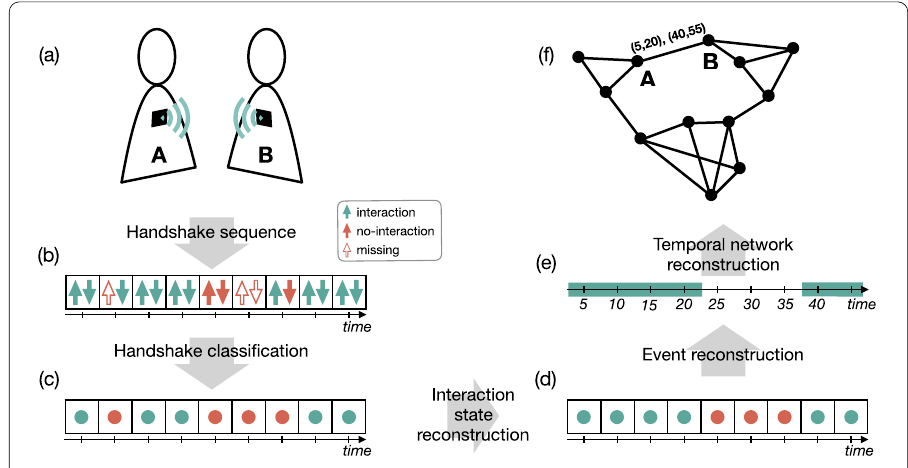
Figure 1 Temporal network reconstruction pipeline. Starting ( a ) from mutually observed packets of pairs of LPWD tags, ( b ) we train models using the raw and annotated data to ( c ) reconstruct interaction and non-interaction periods between individuals to ( d ) reconstruct events and ultimately ( e , f ) build a temporal